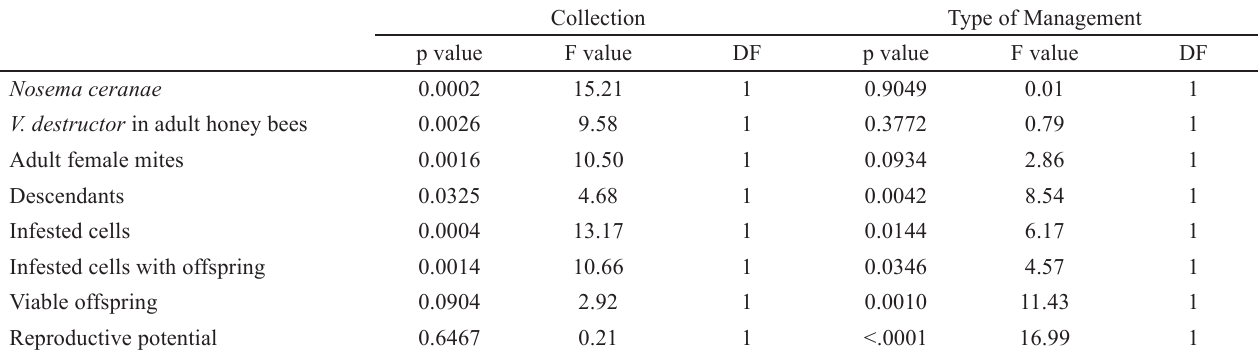
Table 3. Statistical results of infection of N. ceranae in adults honey bees and infestation of V. destructor in adult honey bees and brood